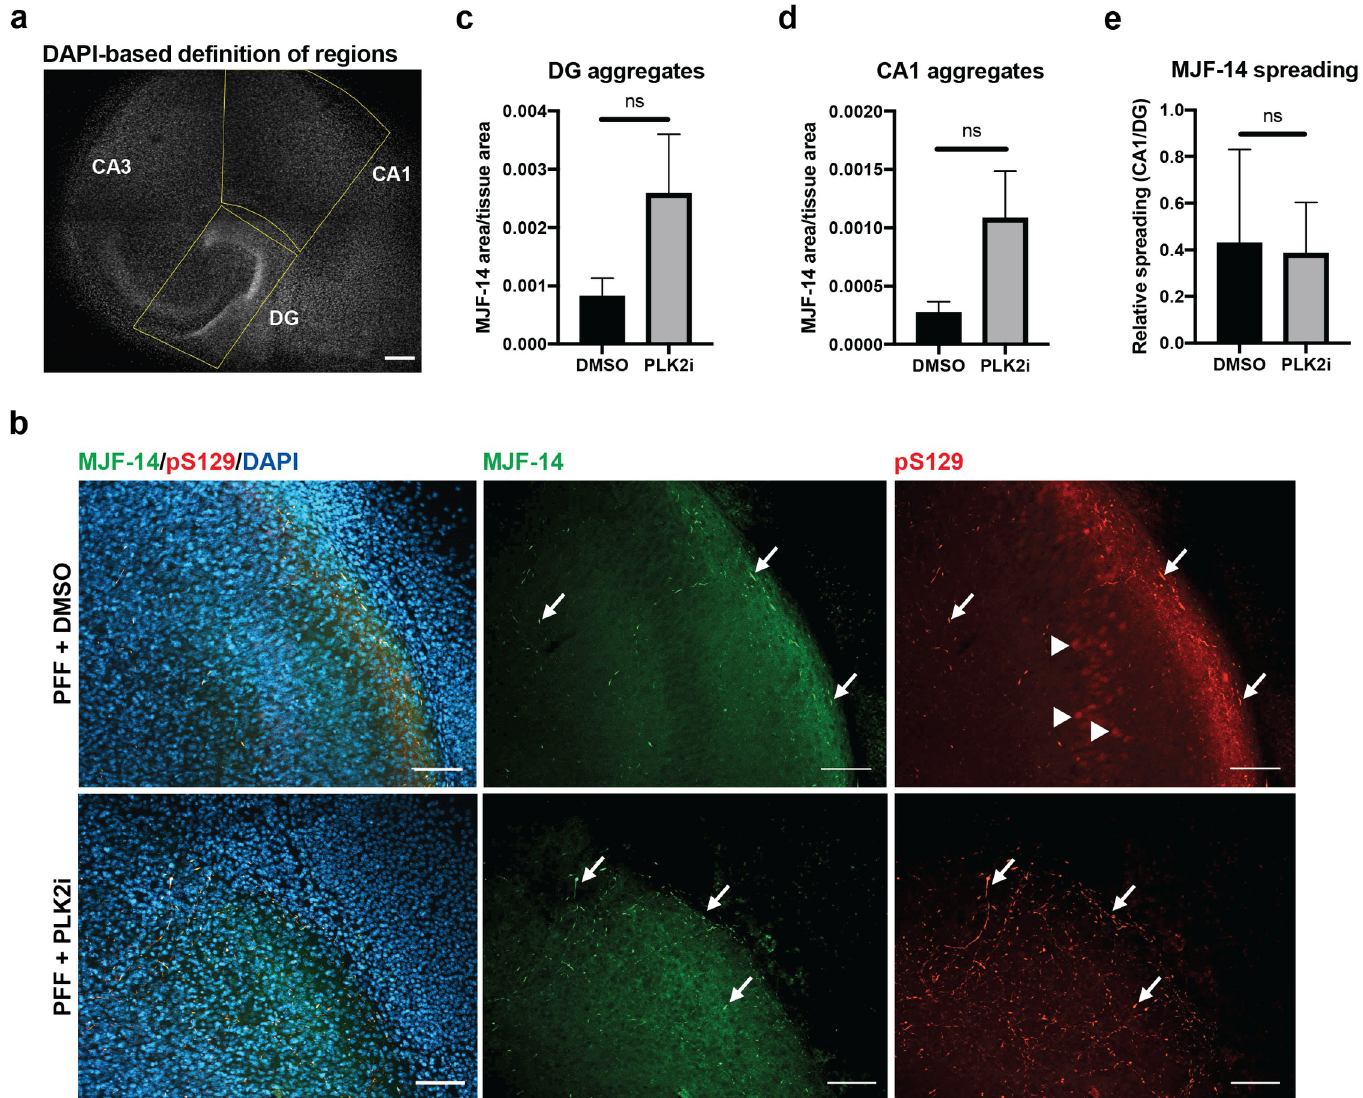
Fig 3. Inter-neuronal spreading of a-syn aggregate pathology from the DG to the CA1 region occurs independently of PLK2 inhibition. a) Segmentation of DG and CA1 regions in organotypic hippocampal slices labelled with DAPI, shown in gray scale. The DG is bounded manually by a box, and the CA1 regions is afterwards defined by extrapolation of one side of the DG box and a diagonal line through the box. Scale bar = 200 μ m. b) Immunostaining of S129A PFF-injected OHSCs showing aggregated α -syn at the CA1 region 7 dpi detected by both MJF-14 and pS129. PLK2i-treatment reduces the nuclear pS129-signal at CA1 that overlaps with DAPI (arrowheads) but has no influence on the PFF-induced aggregate-specific pS129-signal that overlaps with MJF-14-signal (arrows). Scale bars = 50 μ m. c-d) Quantification of α -syn aggregate area (MJF-14 area normalized to tissue area) at the DG (c) and CA1 region (d) shows no significant effects on aggregation at either region following PLK2i treatment. P-values 0.1502 (c) and 0.1048 (d) using an unpaired Welch’s T test. e) Aggregate levels at the CA1 region were normalized to aggregate levels in DG of the same slice to address the relative spreading of S129A PFF-induced α -syn aggregates, based on MJF-14 staining. PLK2i treatment did not affect relative spreading of MJF14-positive pathology (p-value = 0.829 using an unpaired Welch’s T test). Bars represent mean ± SD of 5–6 slices per group. Images are representative of three independent